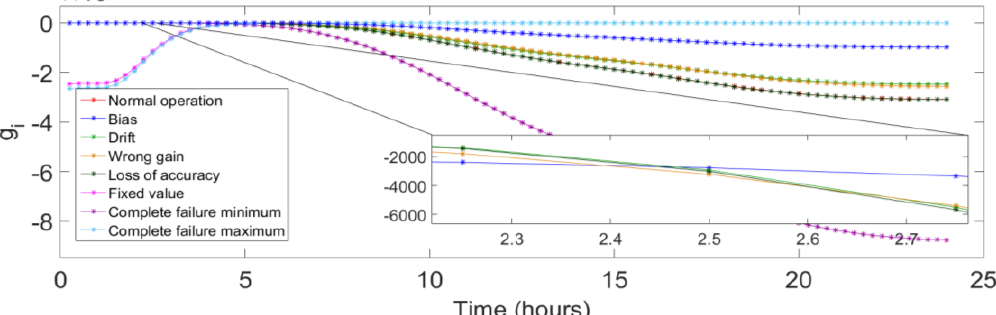
Figure 3. Bias diagnosis: graphs of the FDA discriminant functions gi(x) for each of the normal and seven fault classes, along the 24 h of the 140th day and the detailed representation revealing the class of the observations and the time moment of the firm fault type identification.